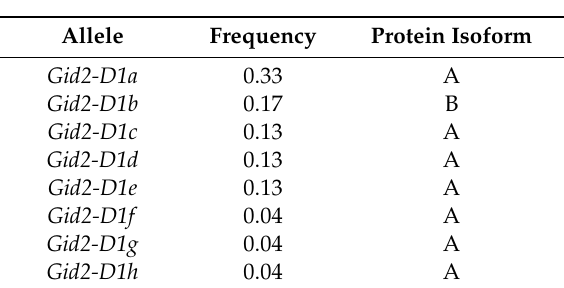
Table 4. Frequencies of the Gid2-D alleles within the studied collection of Ae. tauschii accessions and corresponding protein isoforms.